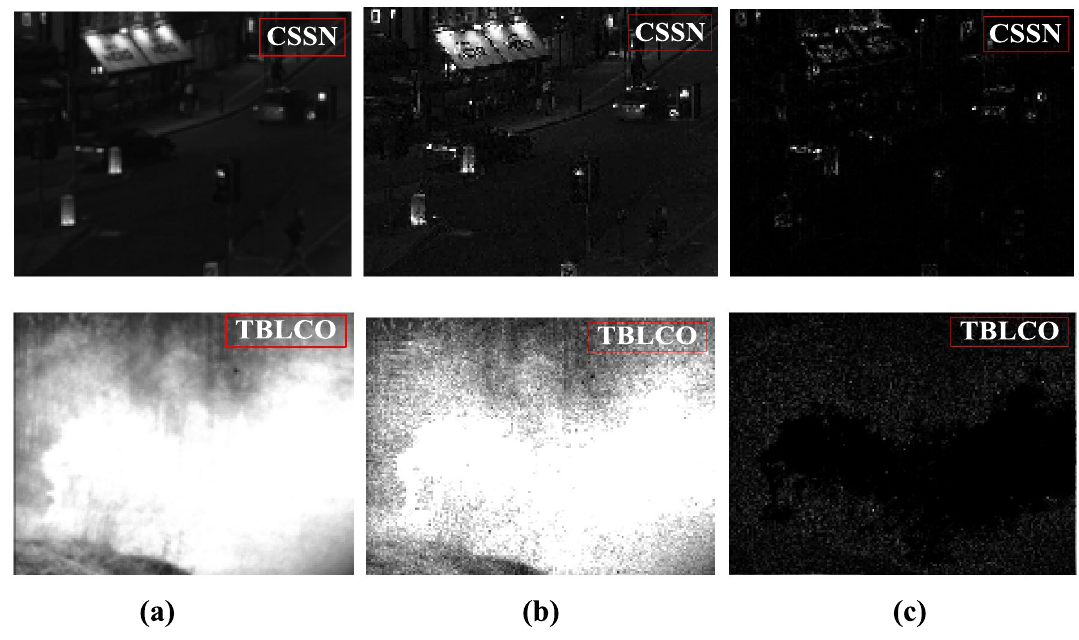
Figure 1. Visible image, basic image and detail image: ( a ) visible image, ( b ) basic image, ( c ) detail